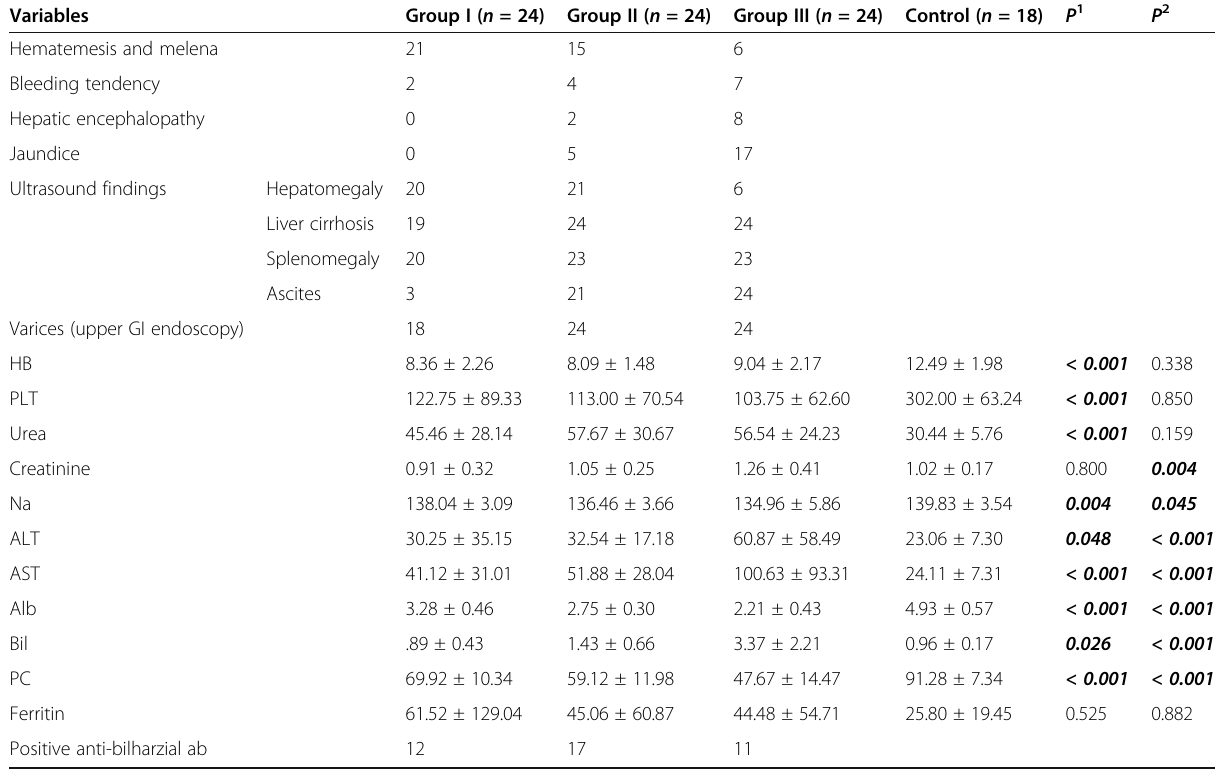
Table 1 Comparison between the three groups of patients and the control group as regards laboratory data using the Kruskal- Wallis test